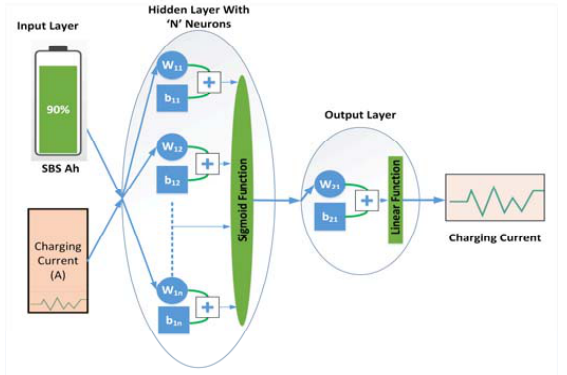
Figure 8. ANN Model. Figure 8. ANN